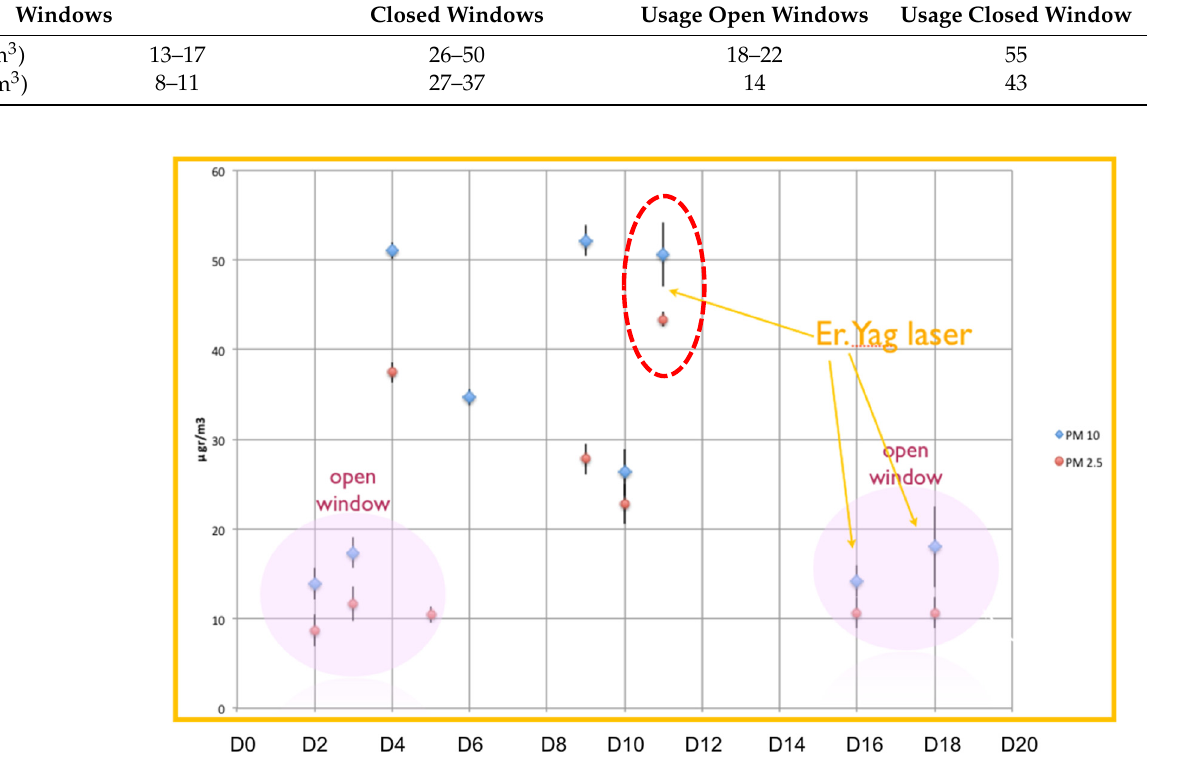
Table 2. Particulate Matter Concentrations ( µ g/m 3 ) over the duration of Experiment 2 (Daily mean values). Background Daily Values Open